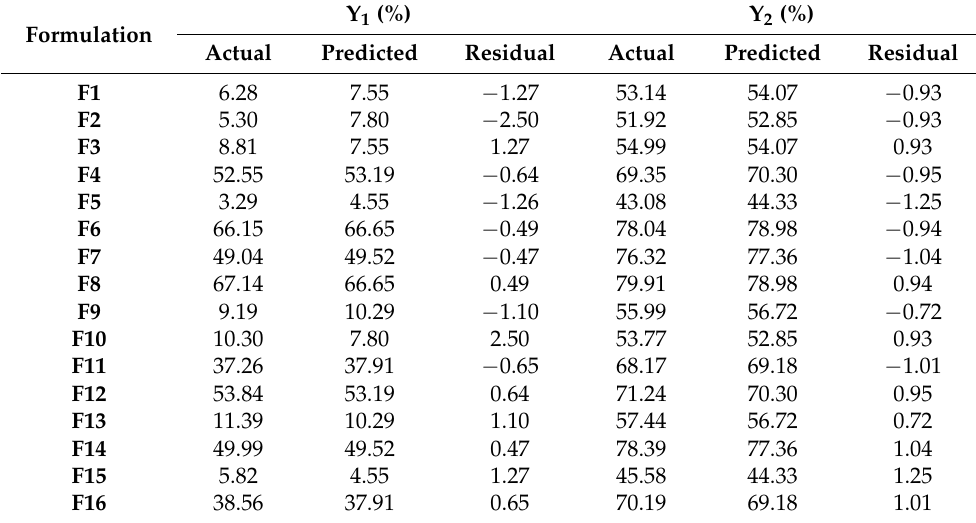
Y 1 , burst release after 6 h; Y 2 , cumulative release after 10